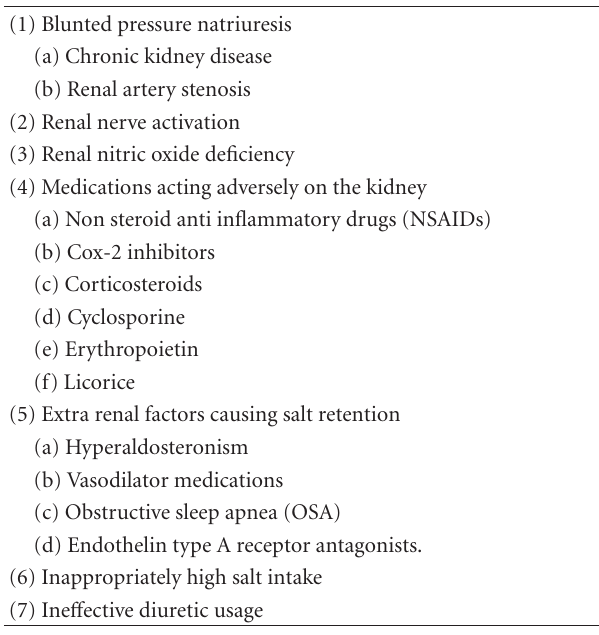
Table 1: Renal mechanisms of drug-resistant